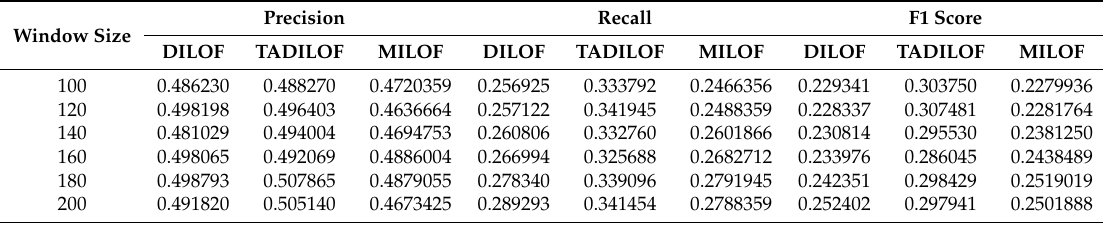
Table 8. Precision, recall, and F1 score on Satellite